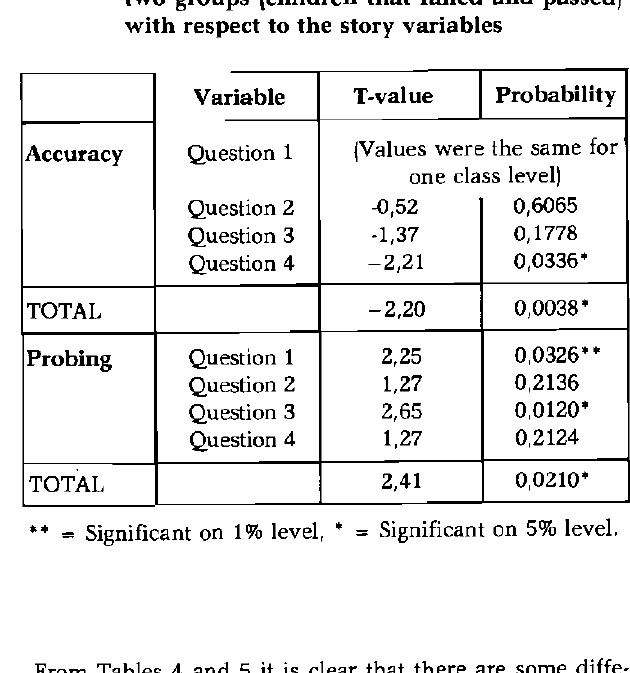
Tables 4 and 5 represent the differences between the means of the story and conversational variables of two groups of children, group 1 representing the children who passed the first year of schooling (65% in total) and group 2 represen- ting those who failed (35% in